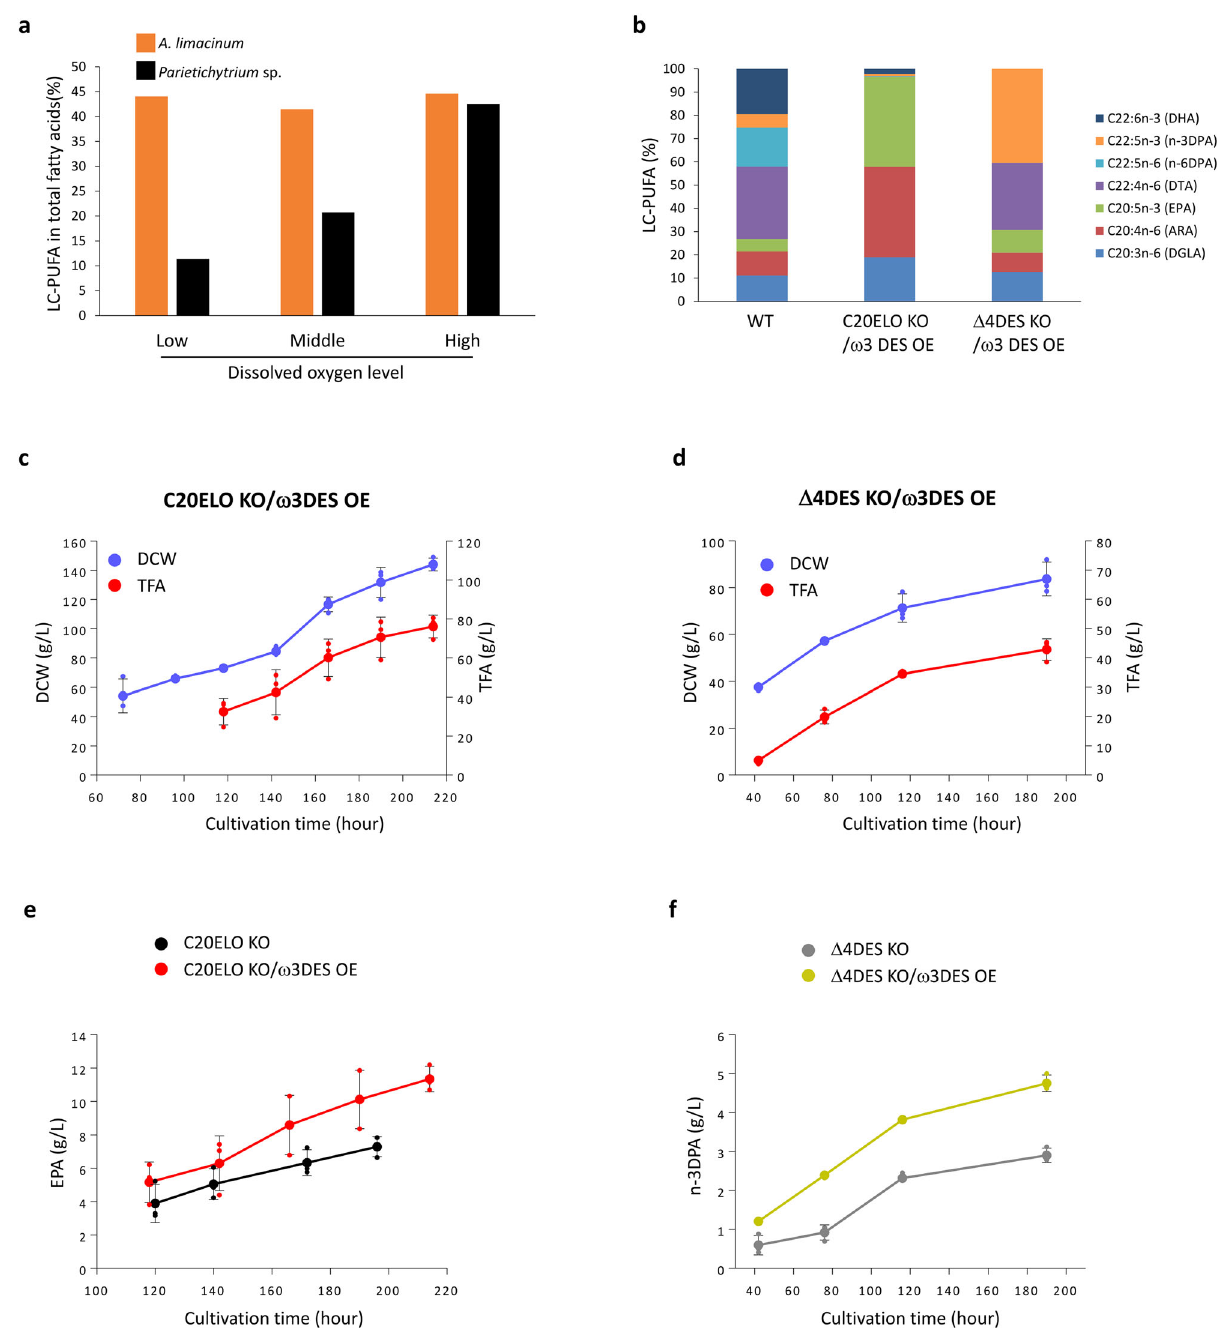
Fig. 3 Production of EPA and n-3DPA using Parietichytrium sp. mutant strains by fed-batch culture. a LC-PUFA levels of Parietichytrium sp. and A. limacinum cultured in the GY medium with different air supply. b LC-PUFA pro fi les of WT, C20ELO KO/ ω 3DES OE, and Δ 4DES KO/ ω 3 DES OE of Parietichytrium sp. SEK358 in fed-batch culture. DCW and TFA of fed-batch culture (1 L jar fermenter) of c C20ELO KO/ ω 3DES OE and d Δ 4DES KO/ ω 3 DES OE. The glucose concentration, DO level, and pH of the medium were monitored and maintained, as described in the “ Methods ” section. e Production of EPA using C20ELO KO and C20ELO KO/ ω 3DES OE in fed-batch culture. f Production of n-3DPA using Δ 4DES KO and Δ 4DES KO/ ω 3DES OE in fed- batch culture. C20ELO KO and C20ELO KO/ ω 3DES OE strains for EPA production, and Δ 4DES KO and Δ 4DES KO/ ω 3DES OE strains for n-3DPA production used in fed batch culture were derived from Parietichytrium sp. SEK364 and SEK358, respectively. Because SEK364 and SEK358 mutants showed superior production of EPA and n-3DPA, respectively, in fed batch culture under the conditions used. The LC-PUFA pro fi les of both mutant strains are very similar (Supplementary Fig. S12a, b). All data shown are the mean ± SD. ( n = 3). The n values are numbers of Similarly, approximately 84 g/L DCW and 43 g/L TFA were PUFAs compared with WT (Fig. 3b). The levels of DCW and obtained after 190 h when the Δ 4DES KO/ ω 3DES OE mutant was TFA in the C20ELO KO/ ω 3DES OE mutant continuously used for fed-batch culture (Fig. 3d). The yield of EPA and increased during the culture period to reach approximately 144 g/ n-3DPA was increased by ω 3DES overexpression, and the yield of L and 76 g/L, respectively, after 214 h in batch culture (Fig. 3c).